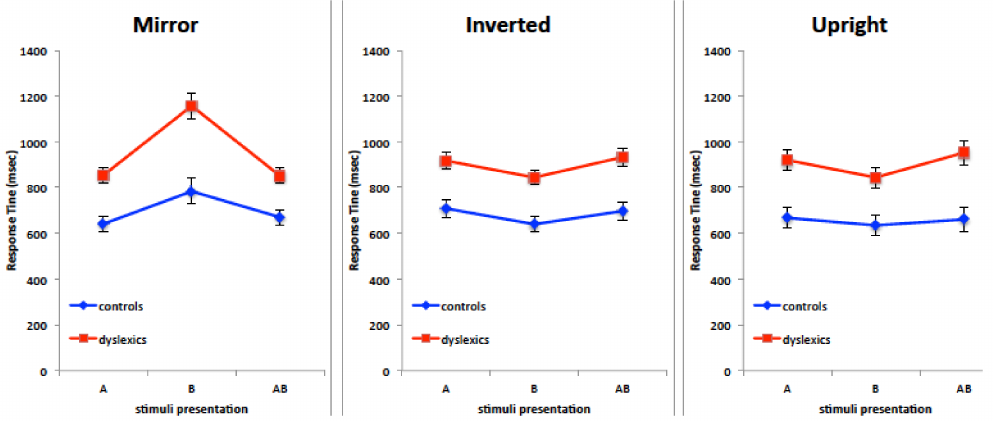
Figure 5. Mean response times of the orientation judgment task for the two children groups (dyslexic participants in red and controls in blue), the three visual field conditions (A: left, B: right, AB: bilateral) and the three stimulus conditions (mirror, inverted and same,